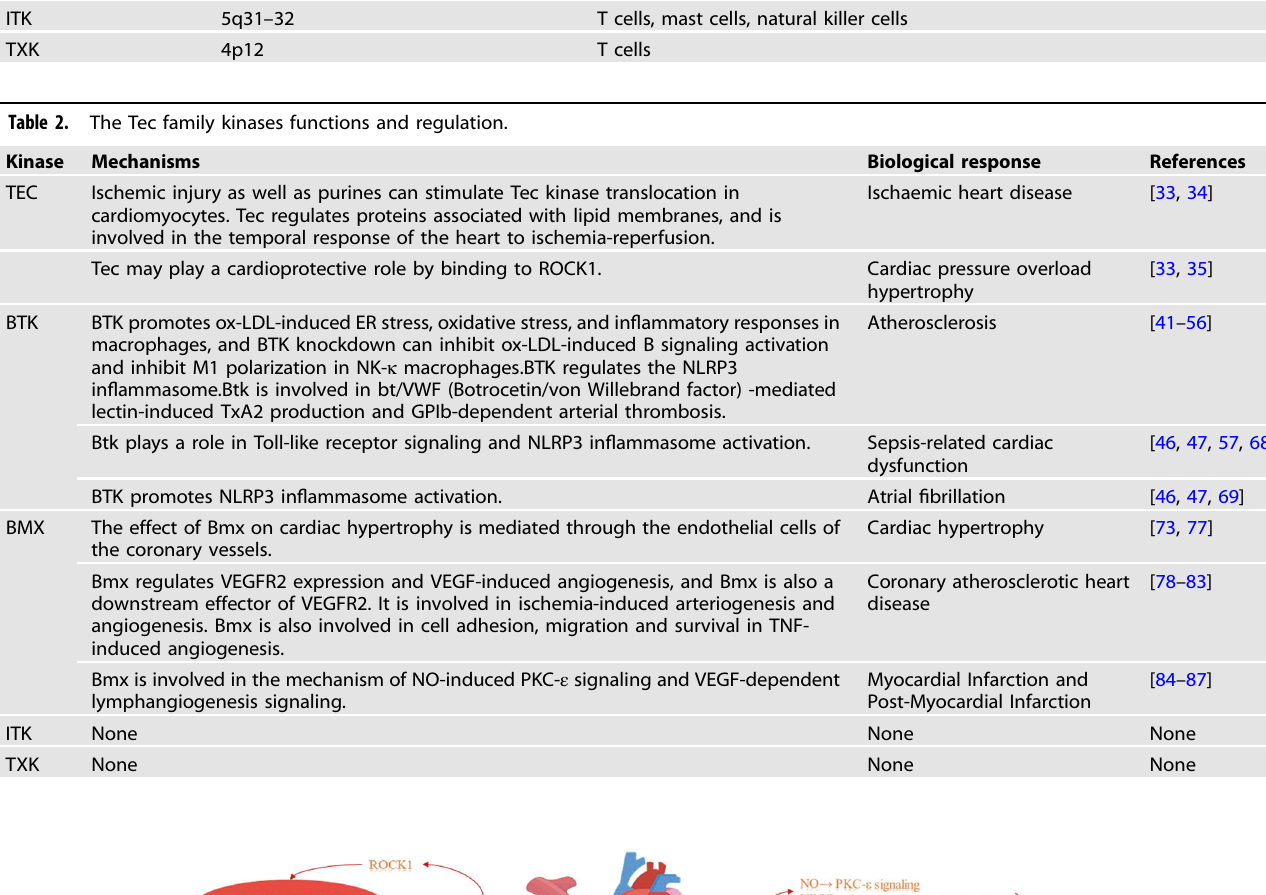
Table 1. Chromosome assignment and expression of Tec family kinases. Kinase